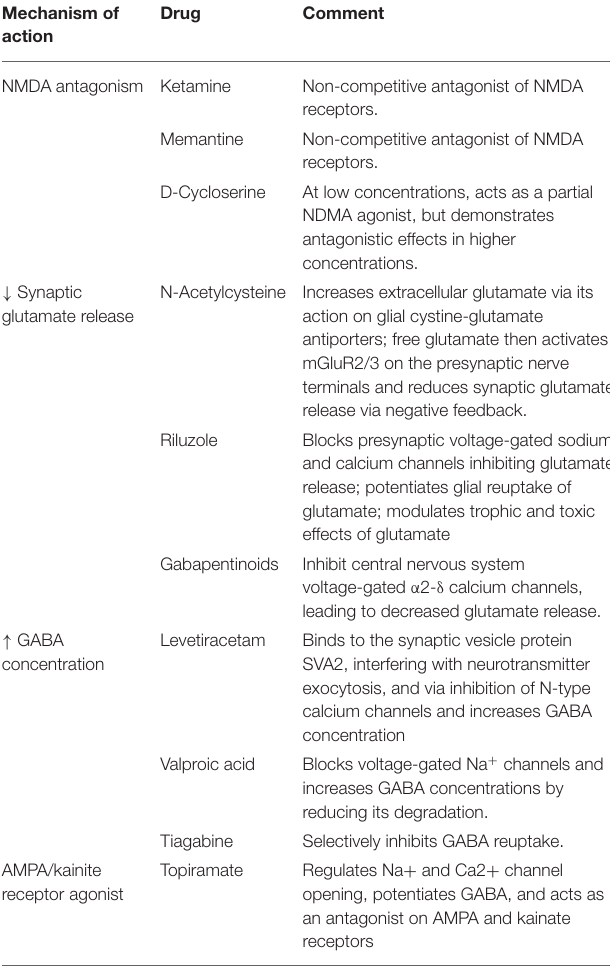
TABLE 1 | Describes the mechanisms with which drugs affect glutamate